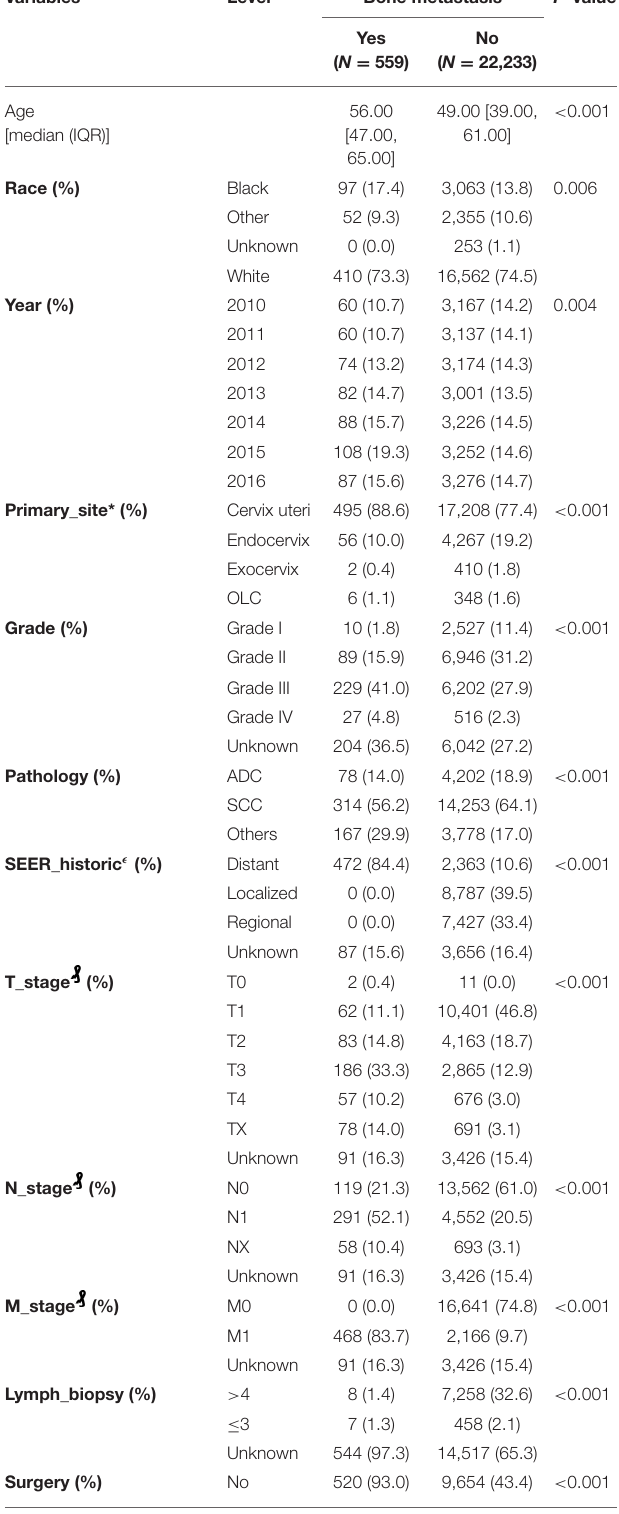
TABLE 1 | Baseline demographic and clinical characteristics of included patients diagnosed with and without bone metastasis.